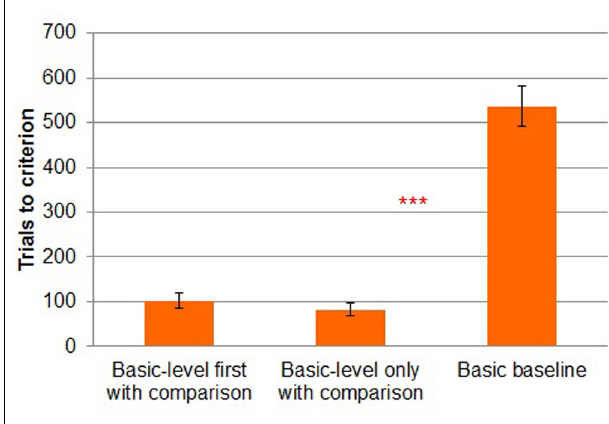
FIGURE 5 |Trials to criterion by study condition in Experiment 2. Error bars represent SEs. *** p < 0.001.